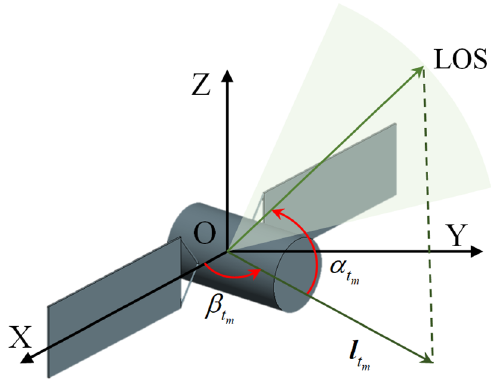
Figure 5. ISAR observation and imaging model.